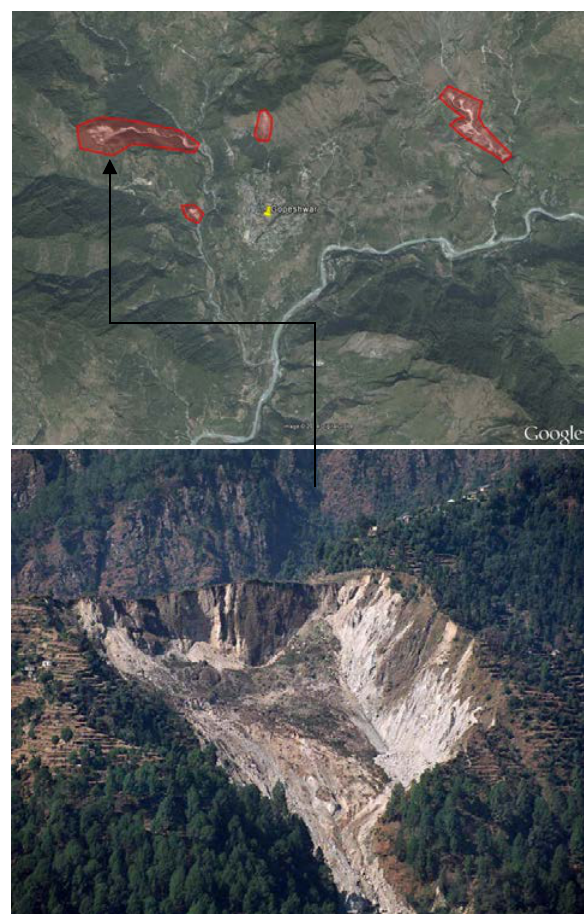
Figure 5: Upper panel: Location of the Kandey landslide and some smaller landslides near Chamoli Gopeshwar highlighted on GoogleEarth (imagery from 10 th May 2006); lower panel: photograph of the release area of the Kandey landslide. Source of photography: IIT- Roorkee.